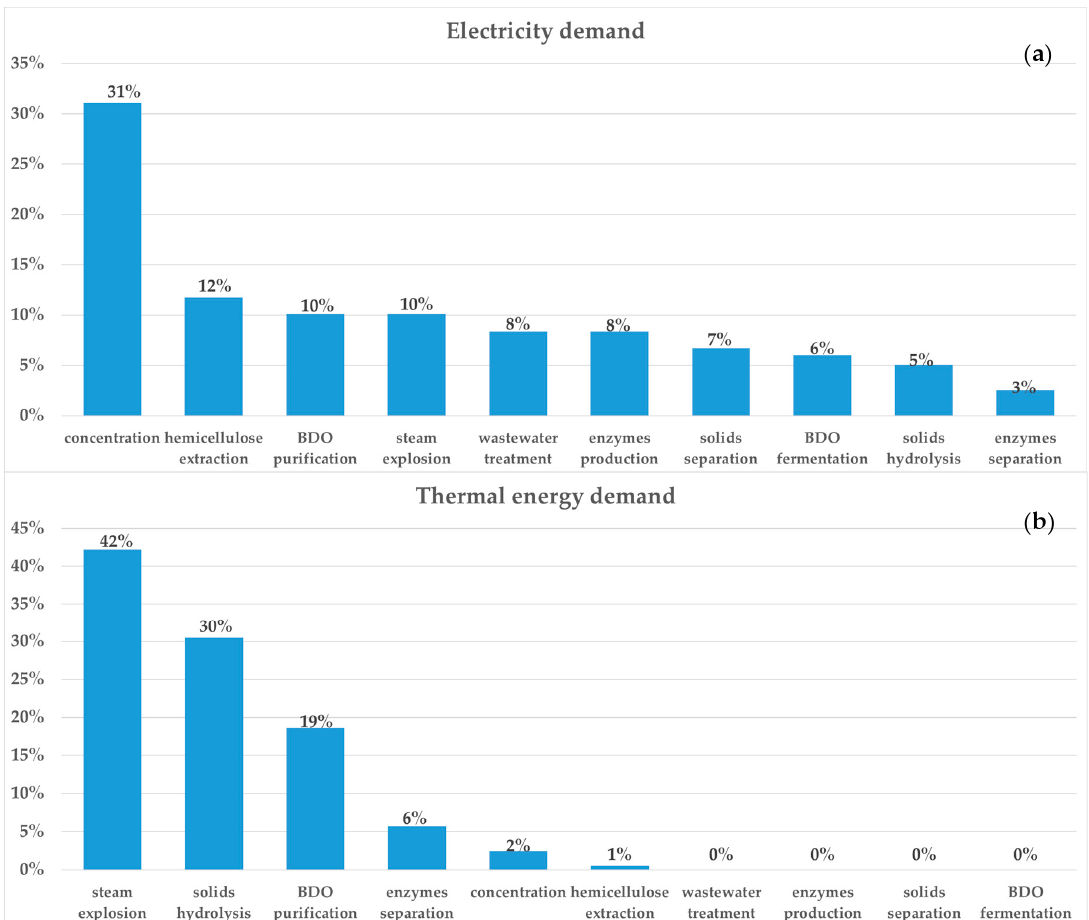
Figure 3. Distribution of electricity ( a ) and thermal ( b ) needs (MWh/year).